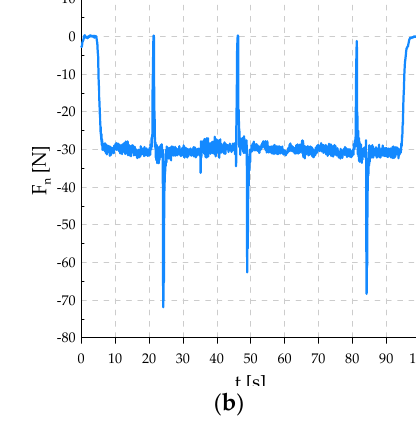
( d ) Figure 10. Realized trajectory of the system: ( a ) TCP coordinates on the directions tangent to the surface of the workpiece; ( b ) downforce; ( c ) TCP velocity in tangent directions; ( d ) derivative of downforce. No large overshoots or oscillations in the force value that could lead to tool damage were observed. The graphs in Figure 11 show the robot errors. The error 𝑐̃ (cid:3051) shows that the tool is deviating from the start position relative to the x -axis excluded in the EGM. The deviation value is within the acceptable range. The greatest changes can be observed at the moment of changes in the direction of motion as short-term peaks not exceeding ±0.3 mm. Large and fast changes in the force error were recorded, which resulted from the shape of the workpiece surface. The sharp ending of the edge of the fault between the flat bars causes a sudden loss of contact at the beginning of the fault and a sudden collision with the edge at the end. During the periods of travel on an even surface of the workpiece, the force value is kept with an error below ±5 N.